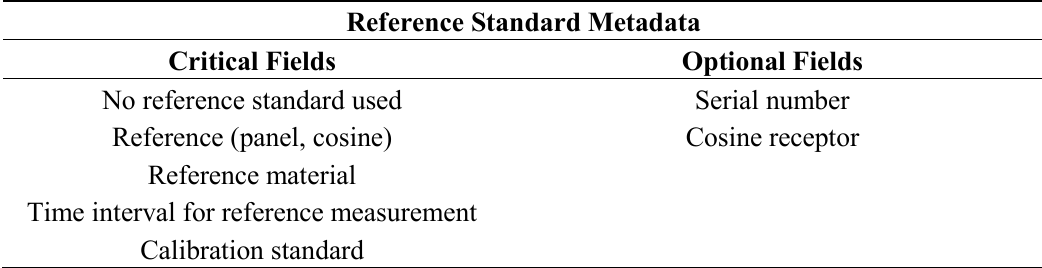
Table 4. Critical and optional fields in the ―Reference Standard‖ metadata category.